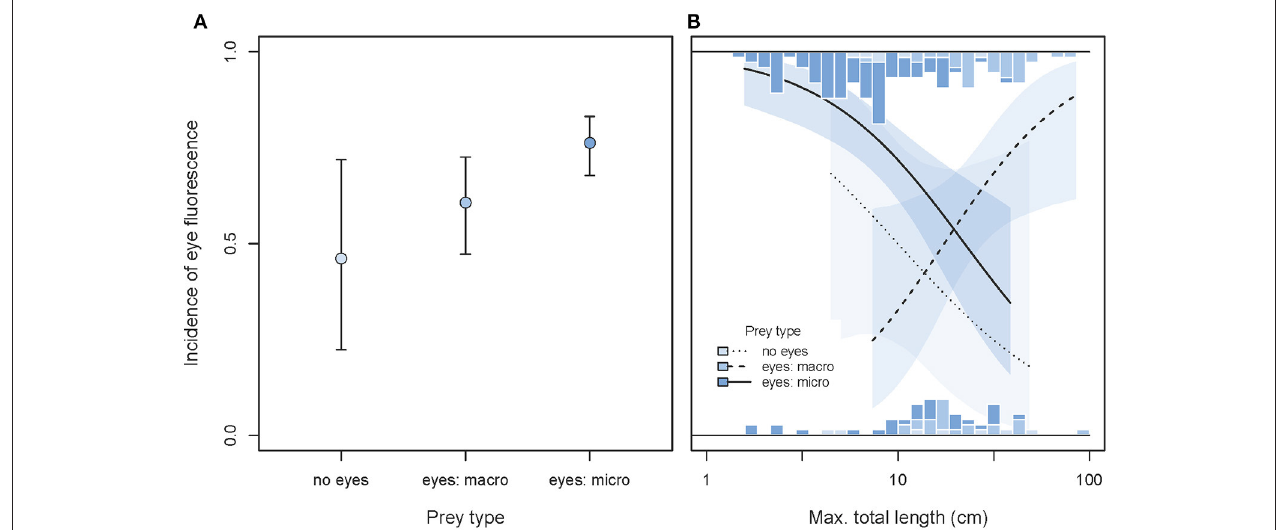
FIGURE 12 | Incidence of eye fluorescence as predicted by prey types, maximum total body length, and their interaction. (A) Shows the overall predicted incidences of eye fluorescence ( ± 95% credibility intervals), pooling across body size. (B) Illustrates the interaction between prey types and body length (note log 10 x -scale). Marginal stacked histograms display the relative frequency distributions of raw species values. Predicted incidences (lines) and their 95% credibility intervals (shaded areas) are extracted from binomial models taking shared species ancestry into